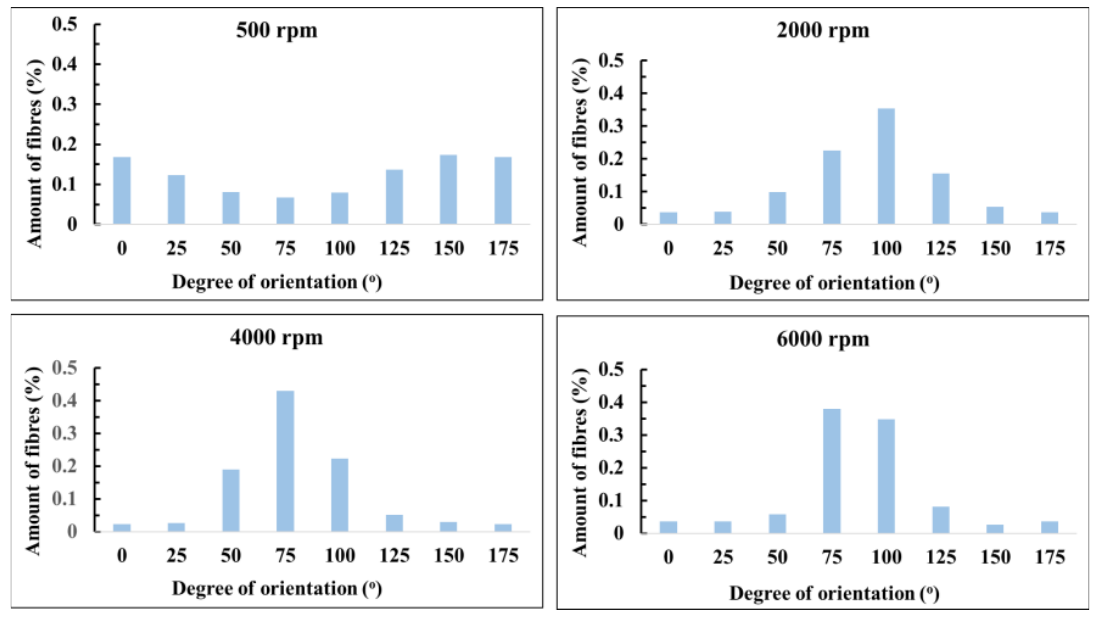
Figure 8. Orientation distribution of aligned meshes.